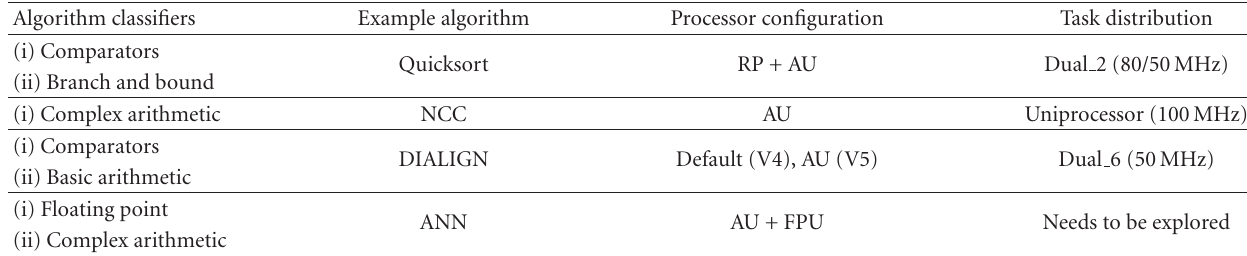
Table 16: First approach for a developers